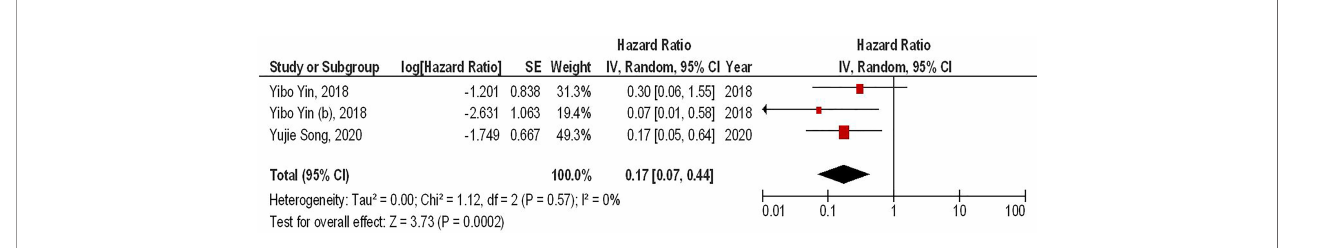
FIGURE 2 | The forest plot of studies evaluating the effect of anti-PD-1 administration on the survival of animal models treated with second-generation CAR-T